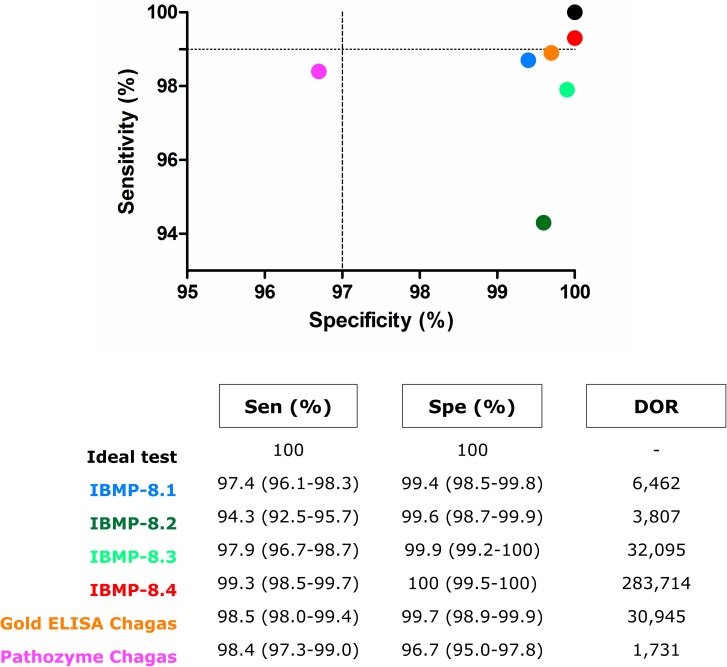
Sensitivity vs. specificity data of IBMP chimeras and two commercial ELISA T. cruzi assays.The black dot represents an ideal diagnostic test that is 100% accurate.